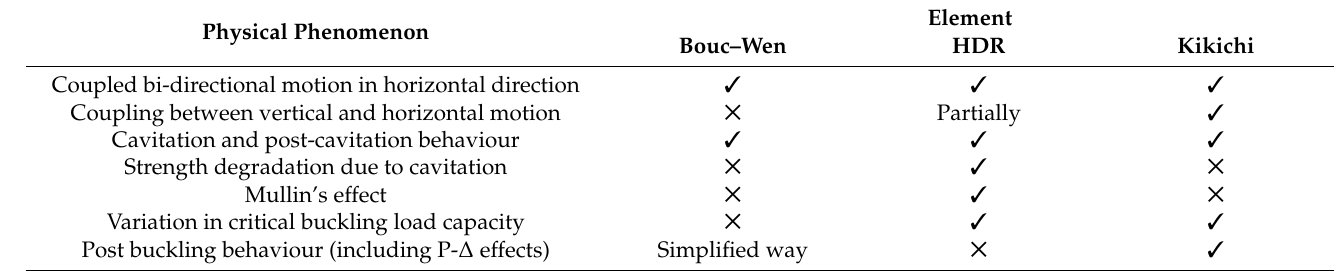
Table 4. Main peculiarities in capturing the bearing response of the examined numerical